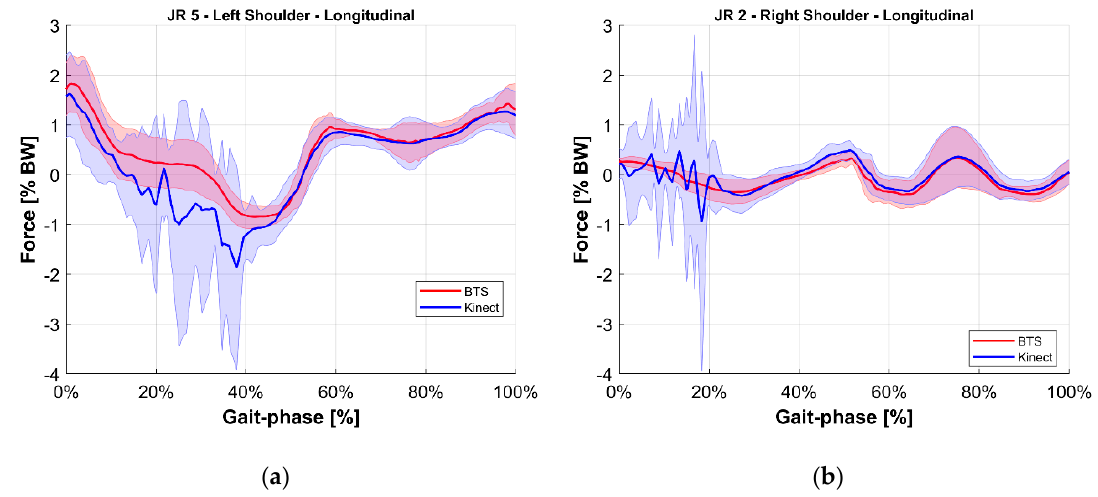
Figure 10. Longitudinal internal reaction force at the shoulder joint. Blue indicates the M-Kinect assessment and red indicates the reference using BTS marker-based mocap. Bold lines represent the average of all tests. The shaded areas represent their standard deviation. ( a ) Left joint and ( b ) right joint. The subject was right-dominant.